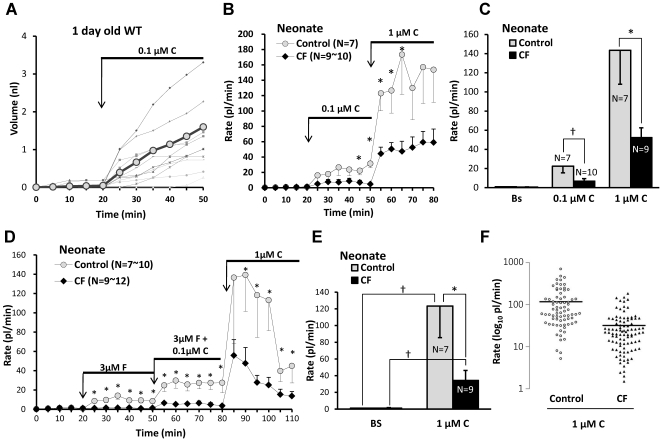
Carbachol-stimulated secretion from CF nasal submucosal glands is reduced.All data are from a one day old WT pig. A, A representative experiment plotting mucus volume as a function of time and stimulation with 0.1 µM carbachol for 12 nasal glands from a newborn WT piglet. Thicker plot line and gray circle symbols indicate averaged volume. B, Average secretion rates as a function of time and stimulation for 7 control and 9–10 CF piglets stimulated with 0.1 µM and then 1 µM carbachol. C, Summary data: 1 µM carbachol caused a significant increase is secretion from nasal glands of both control and CF piglets; the response in CF piglets was significantly smaller than in control piglets († indicates Mann-Whitney test, P<0.03, * indicates t-test, P<0.04). Secretion rates to 0.1 µM carbachol were (in pl/min/gland) control: 22.4±7.0 (n = 7) and CF: 6.7±2.6 (n = 10). Rates to 1 µM carbachol were control: 143.5±35.5 (n = 7) and CF was 52.2±10.3 (n = 9). D, Average nasal gland secretion rates as a function of time and stimulation for 10 control and 9–12 CF piglets stimulated sequentially with 3 µM forskolin, 3 µM Forskolin + 0.1 µM carbachol, and 1 µM carbachol. E, Mean basal and 1 µM carbachol- stimulated secretory rates from experiment shown in (D). Bars represent the average secretion rates for the 30 min period following addition of carbachol, the difference between this graph and (C) is that carbachol stimulation here directly followed forskolin stimulation after brief washout (* indicates control vs. CF, t-test P<0.05, † indicates paired t-test P<0.03). F, Distribution of secretory rates for all glands in response to 1 µM carbachol.